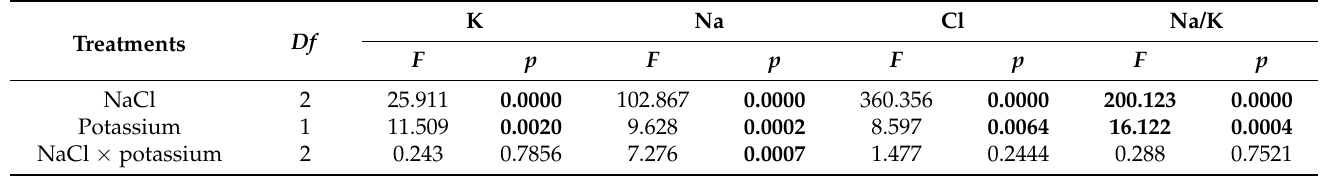
Table 3. ANOVA results for sodium, chlorine, and potassium concentrations in zinnia leaves exposed to salinity stress with two potassium levels in the peat